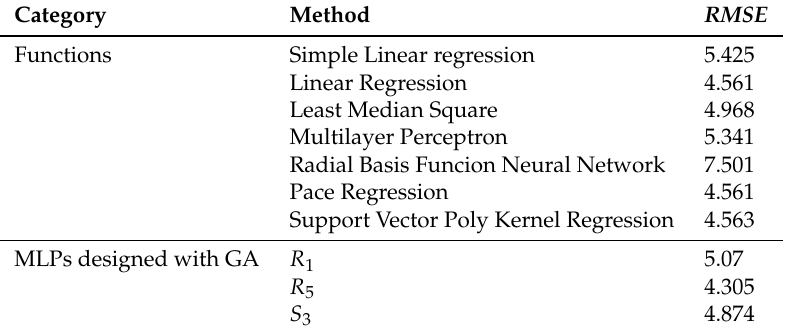
Table 9. Comparison of results achieved with MLPs designed by utilizing GA and other methods presented in the literature.